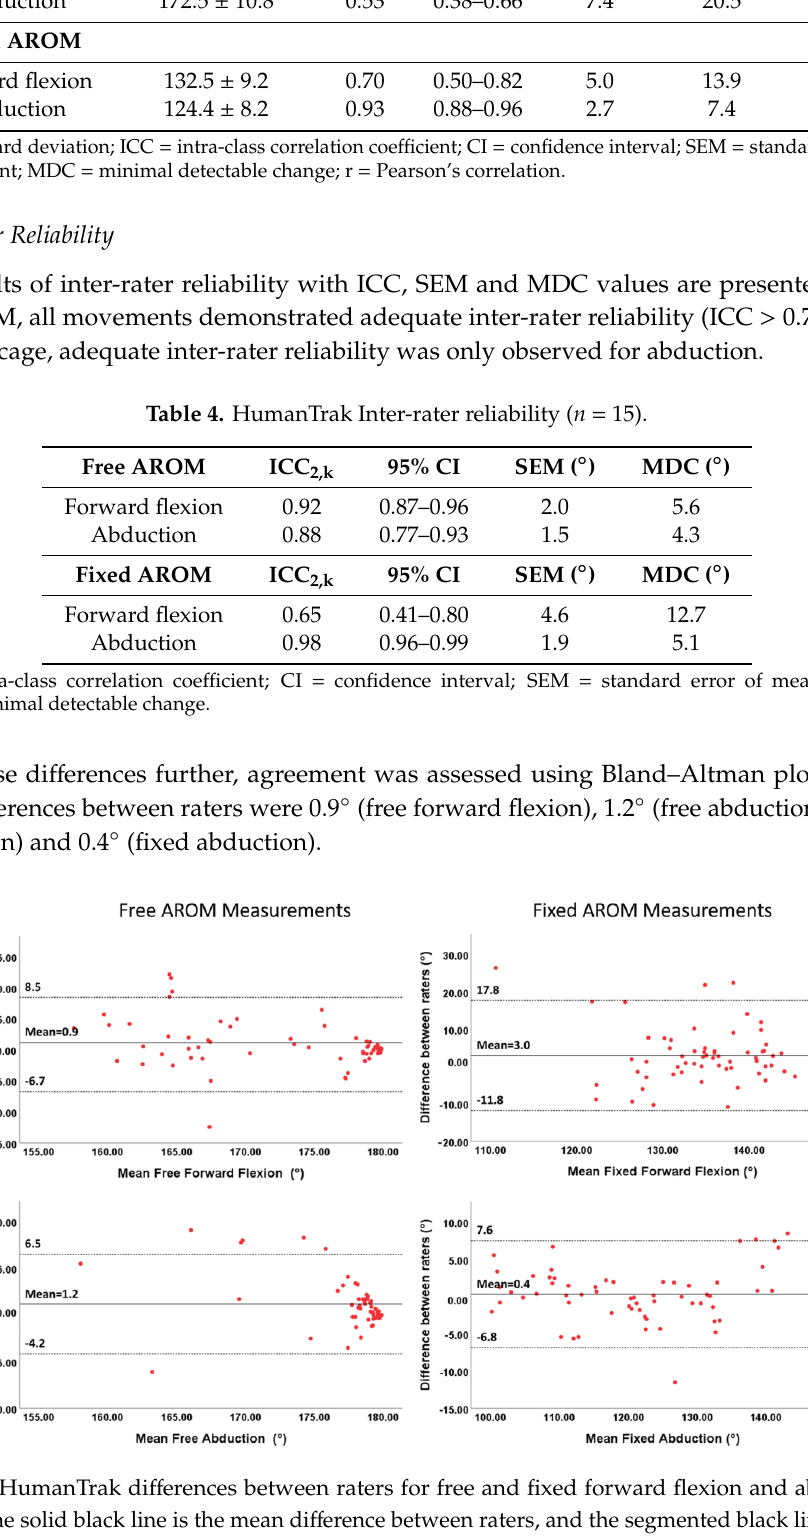
Table 3. Intra-reliability and Pearson’s r (Goniometry) of rater A ( n = 50).